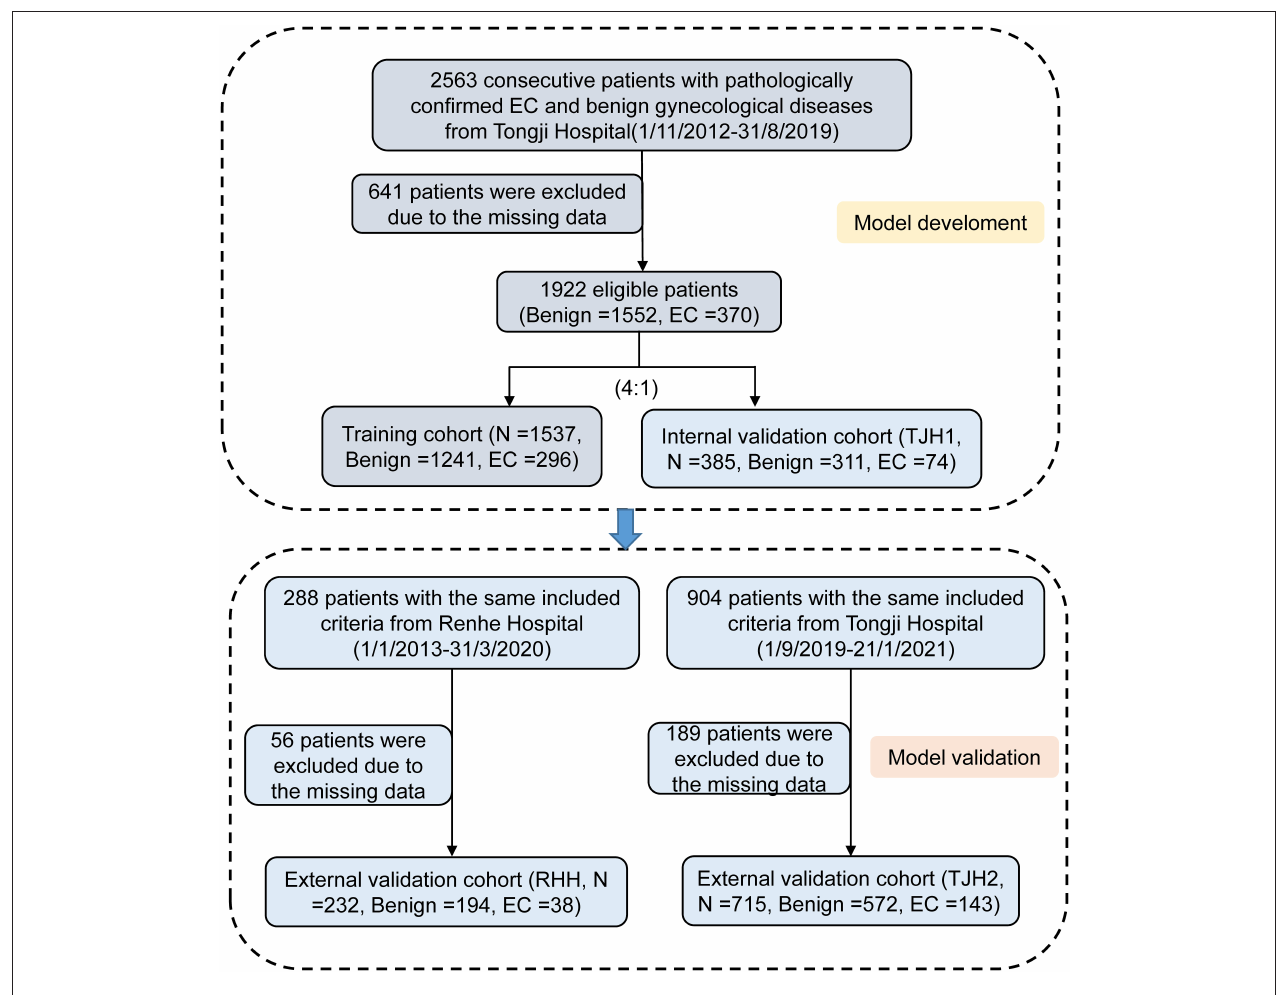
FIGURE 1 | Flow chart of group allocation. EC, endometrial